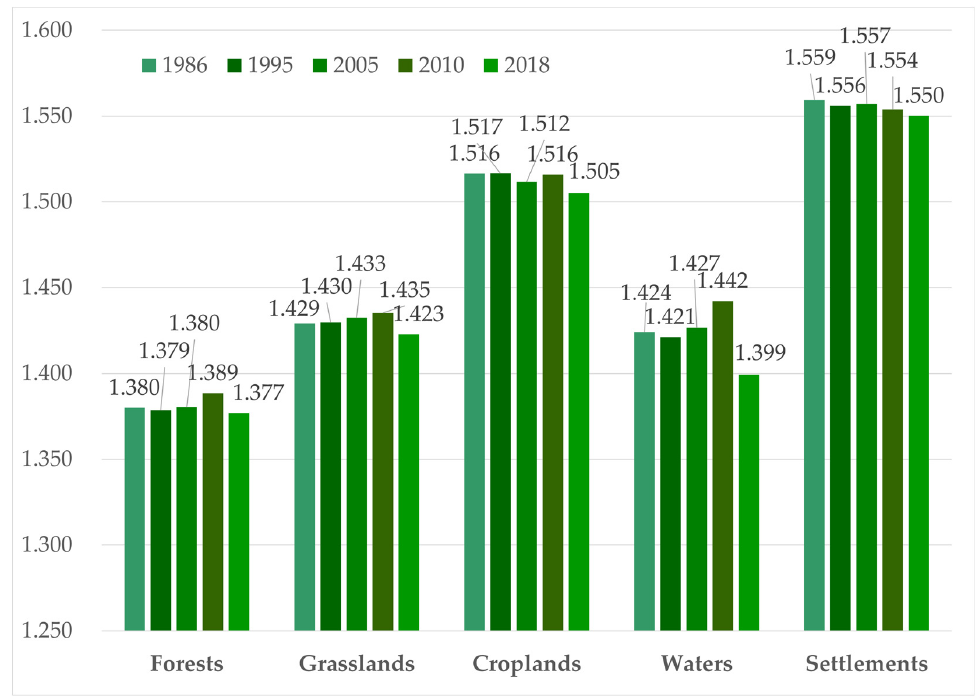
Figure 7. Changes in the PAFRAC from 1986 to 2018.